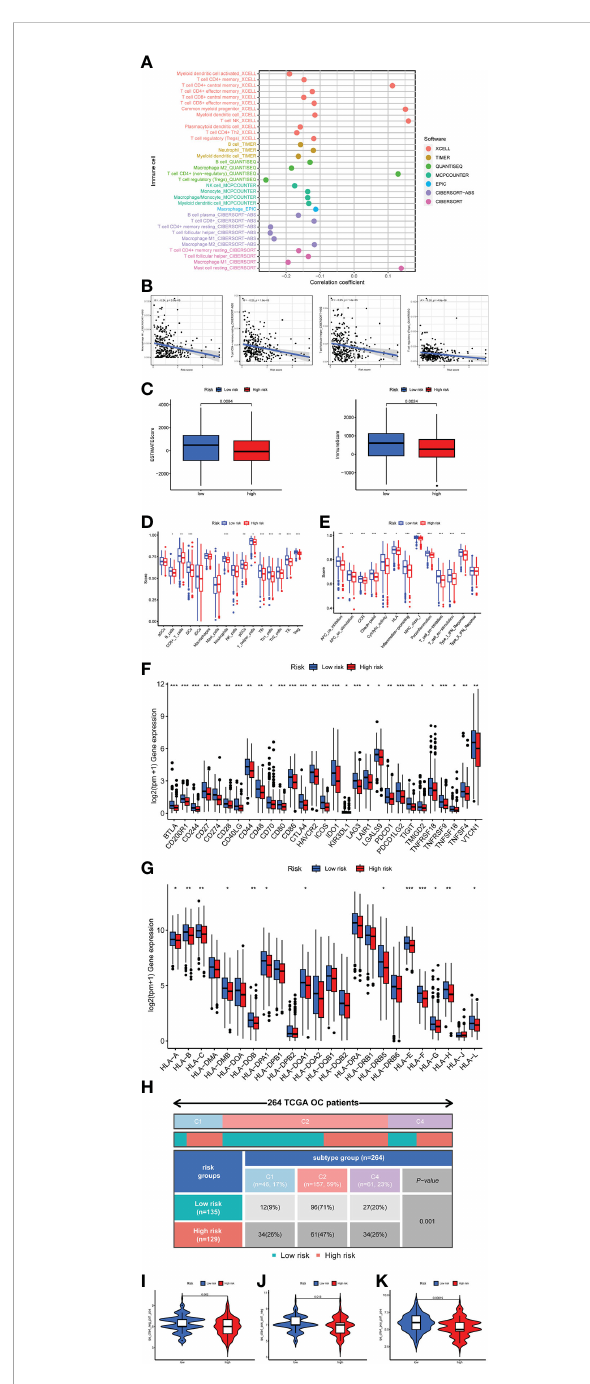
FIGURE 9 Investigation of tumor microenvironment in the high-risk and low- risk subgroups. (A) Correlation bubble plot of the abundance of the immune cells in fi ltration levels with riskscore. (B) A negative association between immune in fi ltration and risk score. (C) Comparison of immune-related scores between the low- and high- risk groups. (D, E) Enrichment analysis of immune cell in fi ltration and immune-related pathways. (F) The difference in the checkpoint expression between the risk groups. (G) The difference in the checkpoint expression between the risk groups. (G) The difference in the expression of human leukocyte antigen (HLA) genes between the risk groups. (H) Immune subtype difference between the risk groups. (I) Immunophenoscore (IPS) for immunotherapy. (I) CTLA4 − PD1+. (J) CTLA4+ PD1 − . (K) CTLA4+